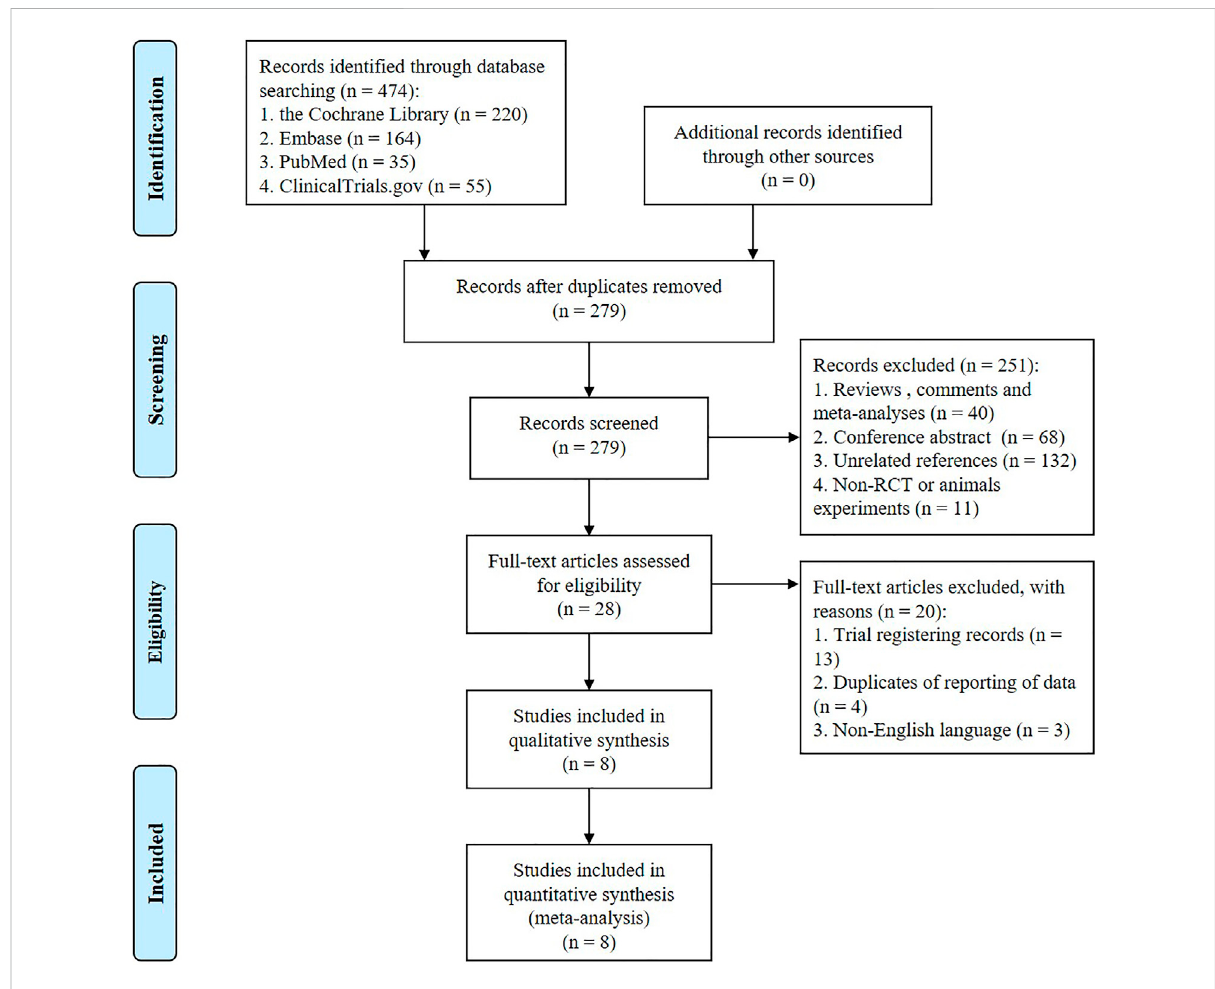
FIGURE 1 Flow diagram of literature